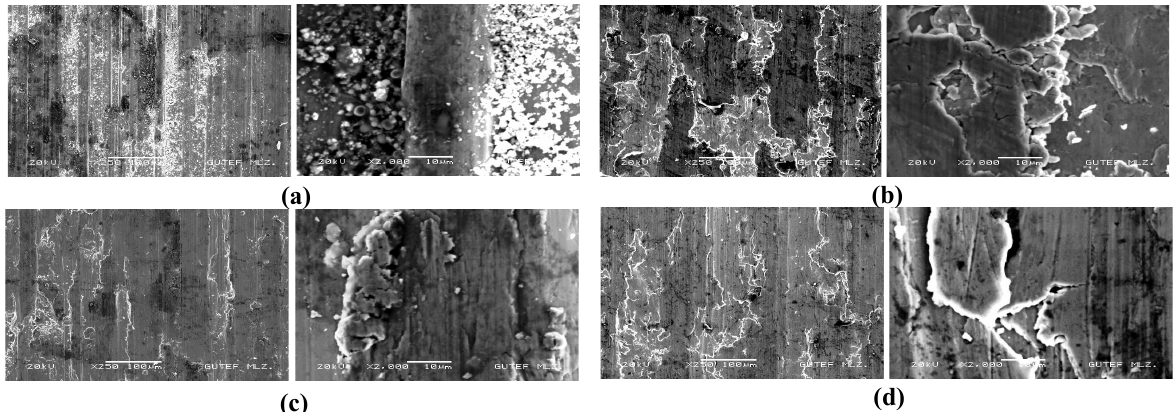
Figure 11. Low ( (cid:2) 250 ) and high ( (cid:2) 2000 ) magnification SEM micrographs of the brasses, which are worn at the 600 m sliding distance, under the 40 N load and at a linear sliding speed of 0.4 m s (cid:3) 1 on the various ductile iron disc. (a) and (b) pearlitic disc, (c) and (d) ferritic disc.